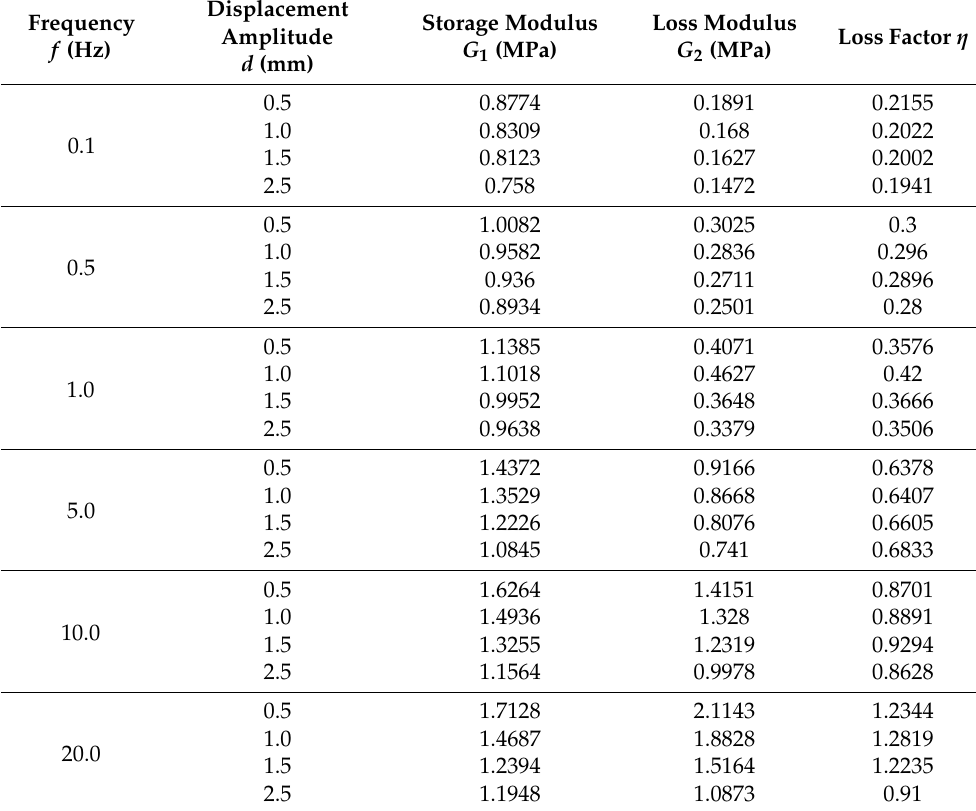
Table 2. Properties parameters G 1 , G 2 , and η of the viscoelastic damper under different